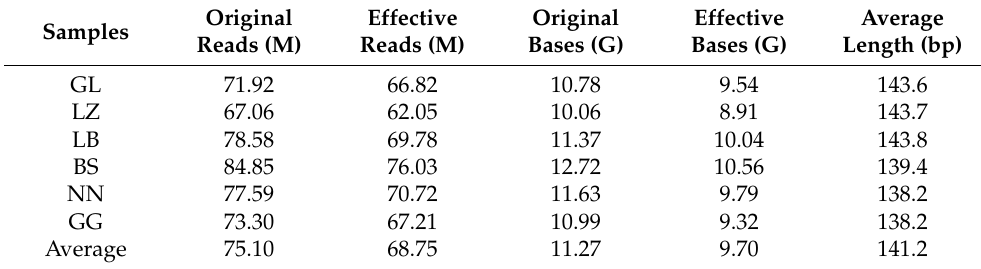
Table 1. Metagenomic sequencing results of different regions’